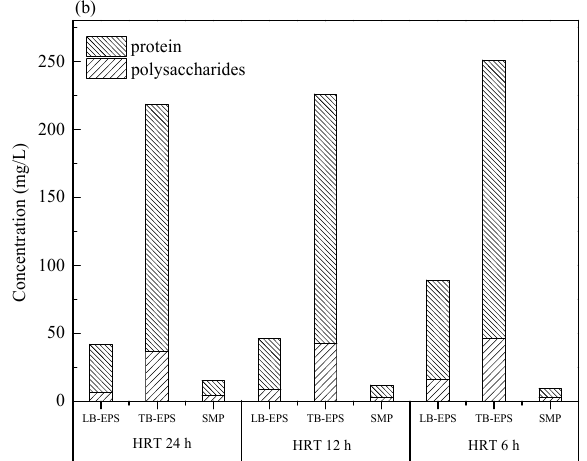
Figure 3. Quantitative analysis of soluble microbial product (SMP) and extracellular polymeric substance (EPS) concentrations in the M-AnMBR ( a ) and A-AnMBR ( b ).